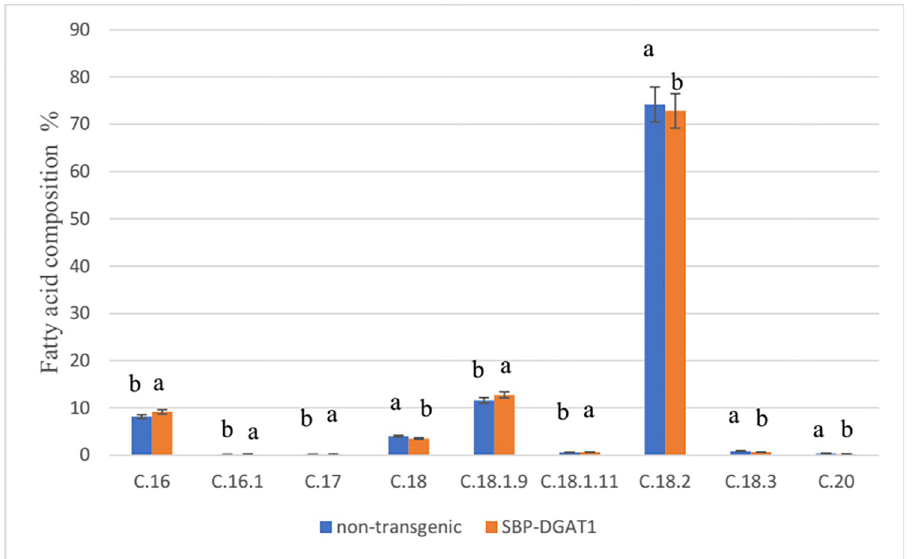
Fig 9. Functional impact of SBP promoter on fatty acid composition in SBP-DGAT1 transgenic plant seeds. Mean values with different letters are significantly different by one-way ANOVA (P < 0.01), n = 6.